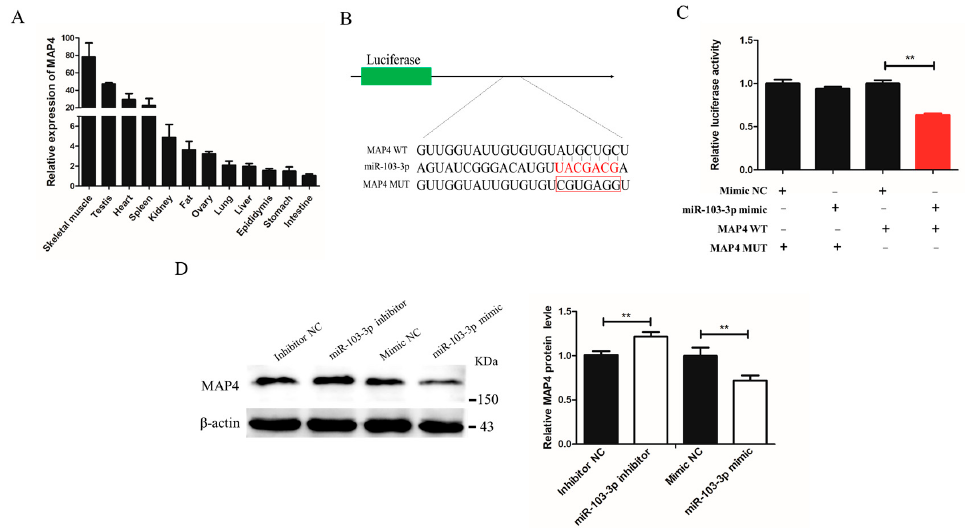
Figure 4. miR-103-3p directly targeted the MAP4 gene. ( A ) Expression of MAP4 in different mouse tissues. n = 3. ( B ) The miR-103-3p binding site in MAP4 3 ′ -UTR with the seed sequence of miR-103-3p and the mutant sequence highlighted in red and in the red box, respectively. ( C ) The relative luciferase activity was analyzed in HEK293t cells that were co-transfected with wild-type or mutant MAP4 3 ′ -UTR with the miR-103-3p mimic or mimic NC by the dual-luciferase reporter assay. The relative luciferase activity was assayed at 48 h. n = 3. ( D ) Western blot analysis of the protein level of MAP4 in C2C12 cells at 48 h after transfection with miR-103-3p inhibitor or mimic. β -Actin was used as endogenous control. Data are expressed as the mean ± SEM, n = 3. ** p < 0.01.